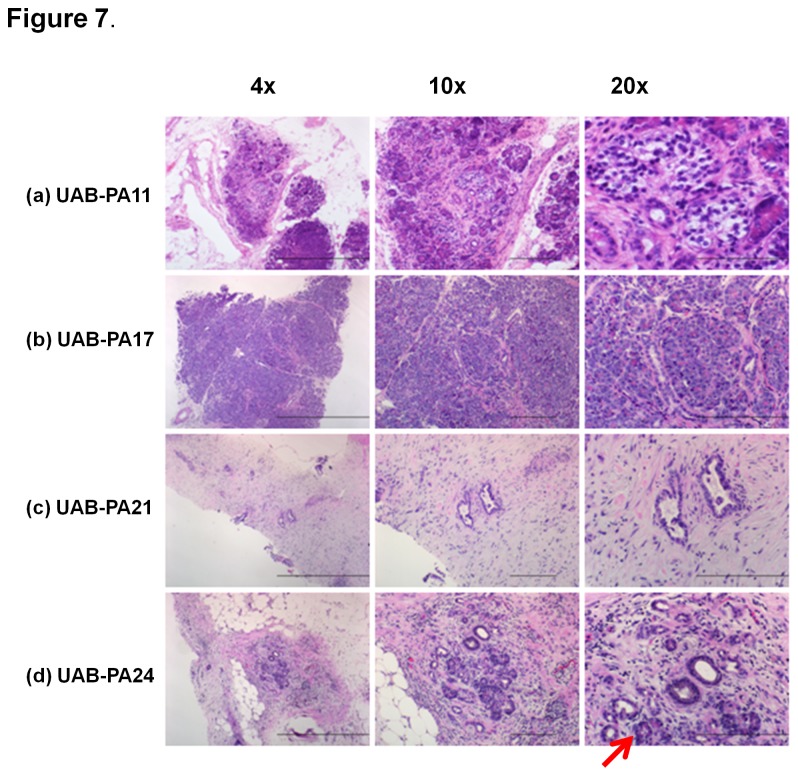
Histological evaluation of primary tumors that failed to grow in mice.Four primary tumor specimens (F0) that failed to produce F1 tumorgrafts were analyzed for their histological features using H&E staining. The photomicrographs show 4x, 10x, and 20x images of each tumorgraft. Bar in 4x = 100 µm; 10x = 20 µm; 20x = 20 µm.